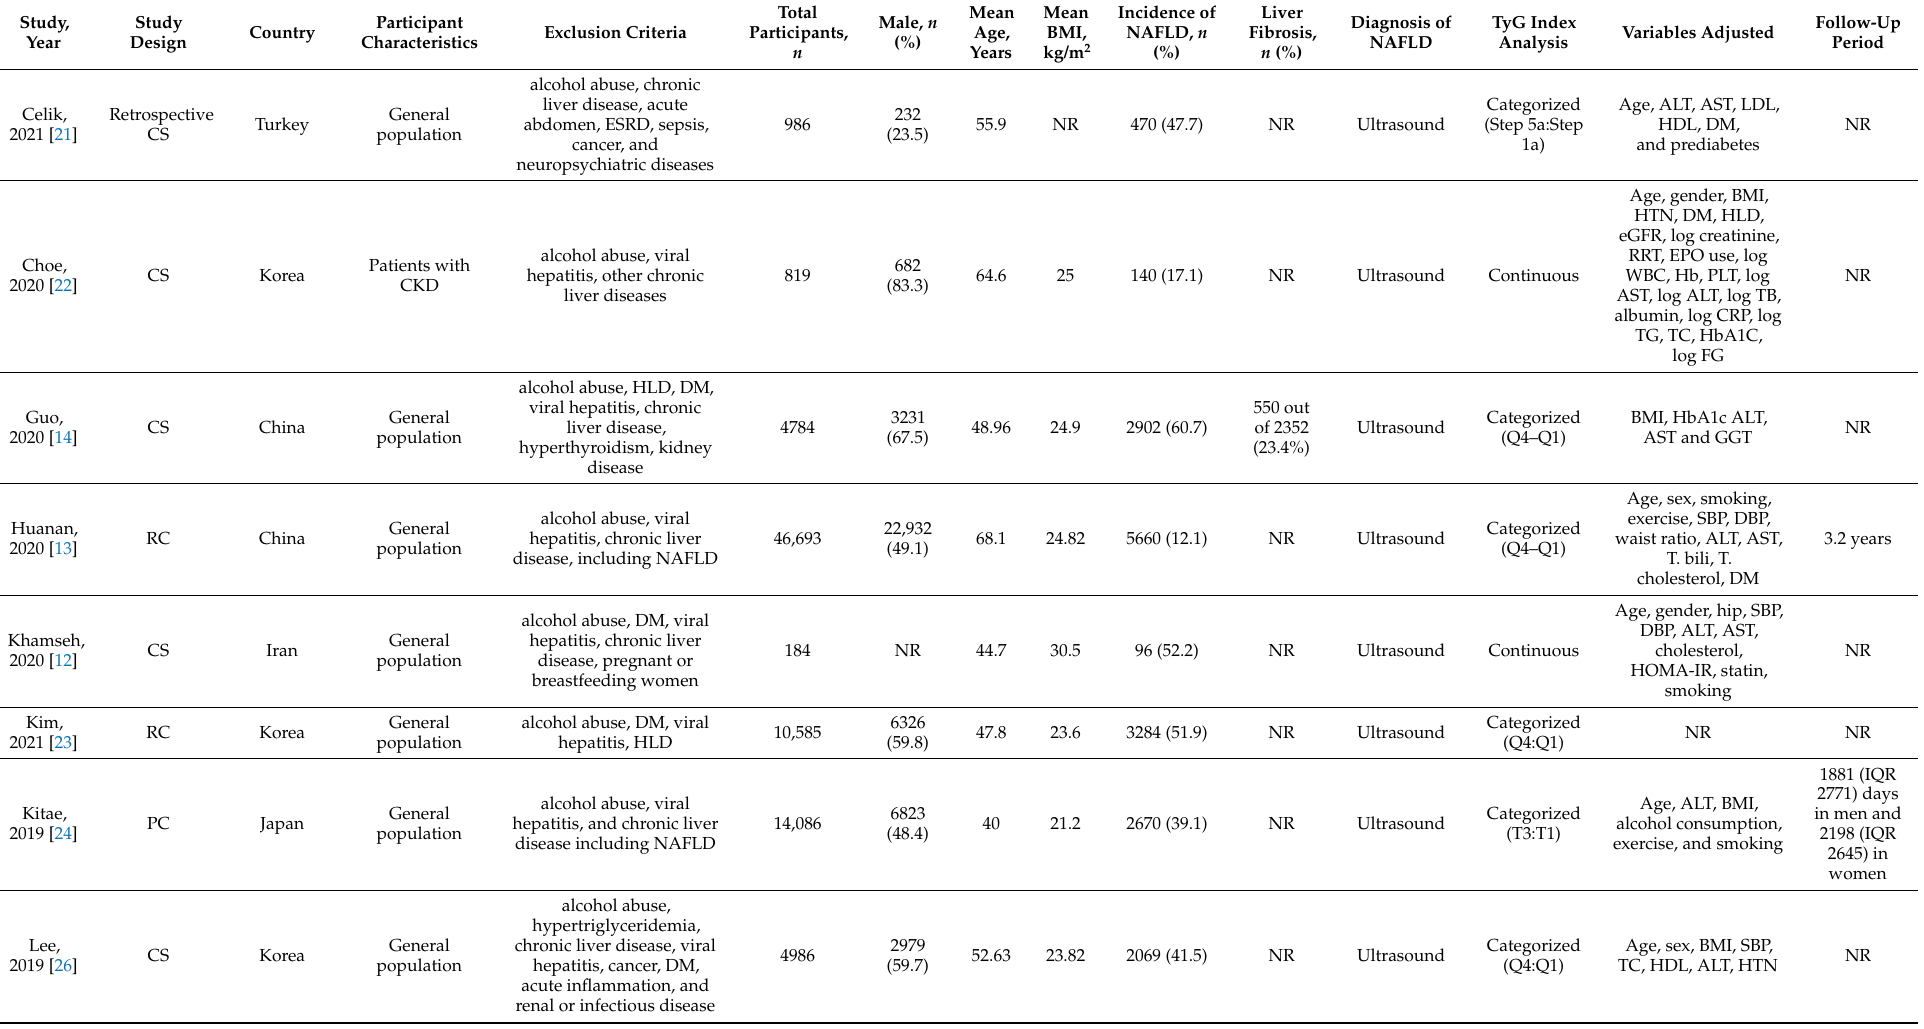
Table 1. Study and participants’ characteristics of the included